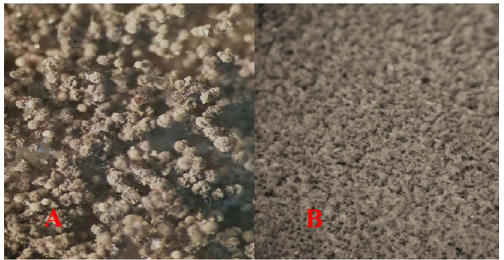
Fig. 3. Microscopic shape of some example of Cultures of some isolated fungi, a: Aspergillus niger , b: Penicillium sp.